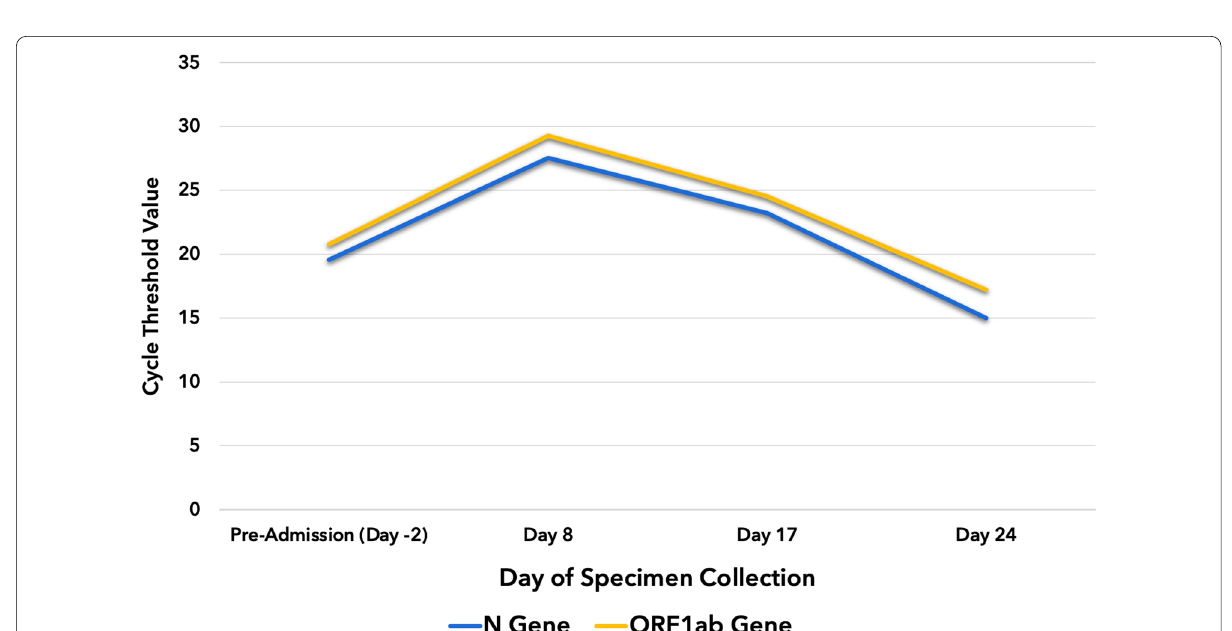
Fig. 5 Changes in the cycle threshold values of SARS‑CoV‑2 genes detected during the patient’s